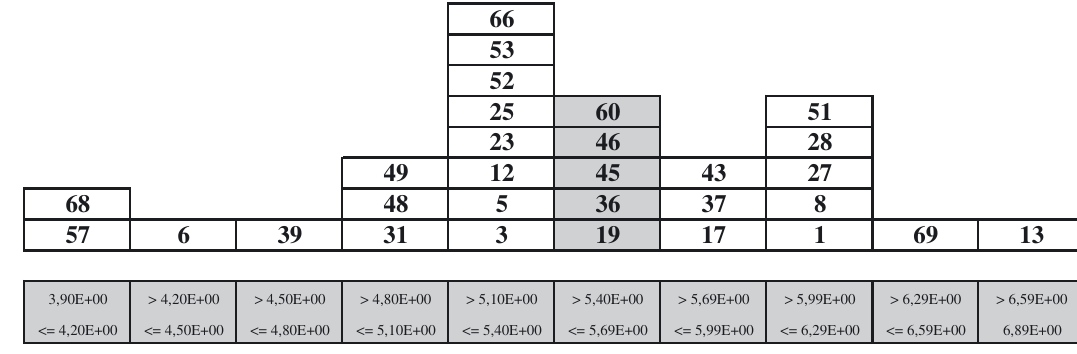
Fig. 2. Diagram of repartition of results for one X or gamma emitter.